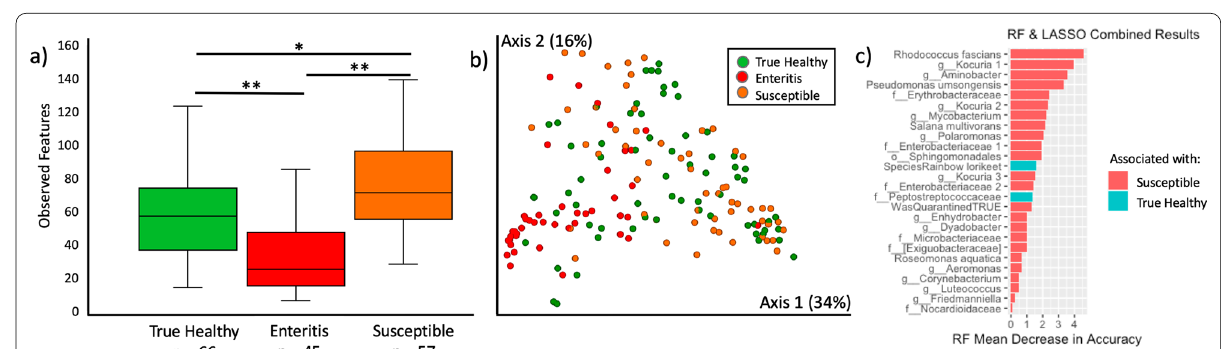
Fig. 5 Susceptible CZA lorikeets have increased microbial diversity and altered microbial composition that predicts enteritis. Healthy lorikeets that never developed enteritis throughout the sampling period were identified as “True Healthy” while healthy birds that developed enteritis at least once during the sampling period were identified as “Susceptible.” “Enteritis” represents birds with enteritis that were sampled while they were clinically ill. No post‑mortem samples are included in this figure. a) Microbial diversity (Observed Features, Kruskal–Wallis, all p < 0.005) was increased and b) microbial composition was altered (PERMANOVA p 0.001) in Susceptible birds. c) Twenty‑six variables including 24 microbial taxa and = two demographic variables were identified in Random Forests and LASSO models as predictive of susceptibility or true health. The size of the bars represents the effect size of each variable as predicted by the RF model. (Also see Additional file